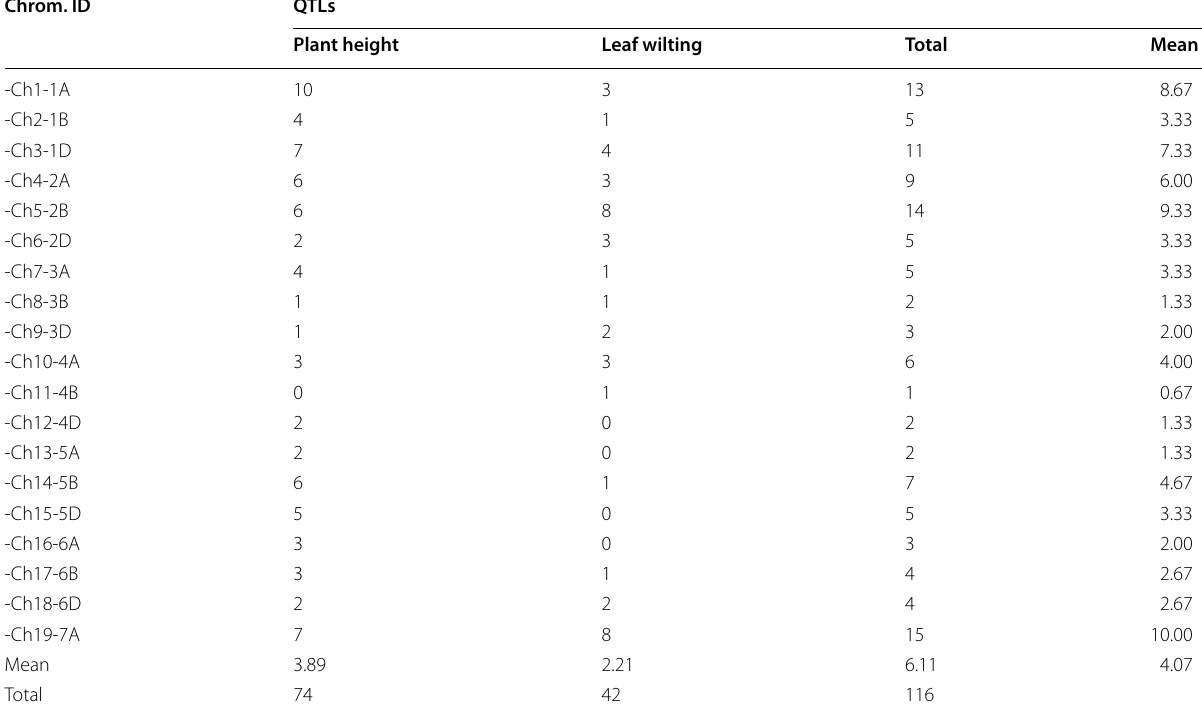
Table 4 Chromosomes ID and their QTLs loci related to plant height and leaf wilting for nineteen chromosomes out of twenty‑one wheat